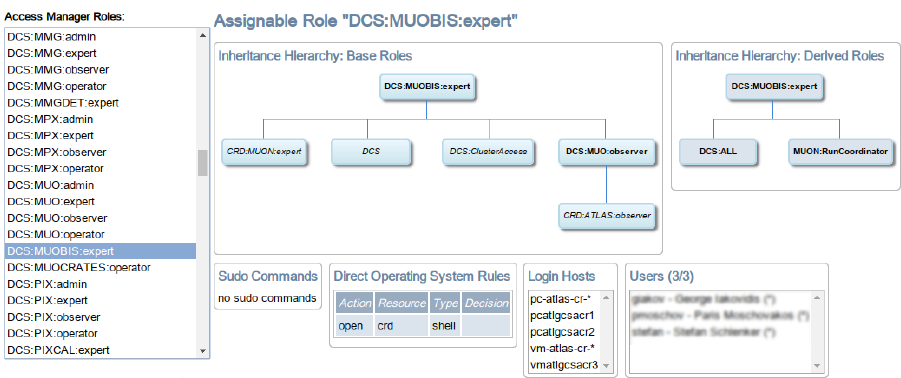
Figure 1. First version of interactive Policy Browser based on